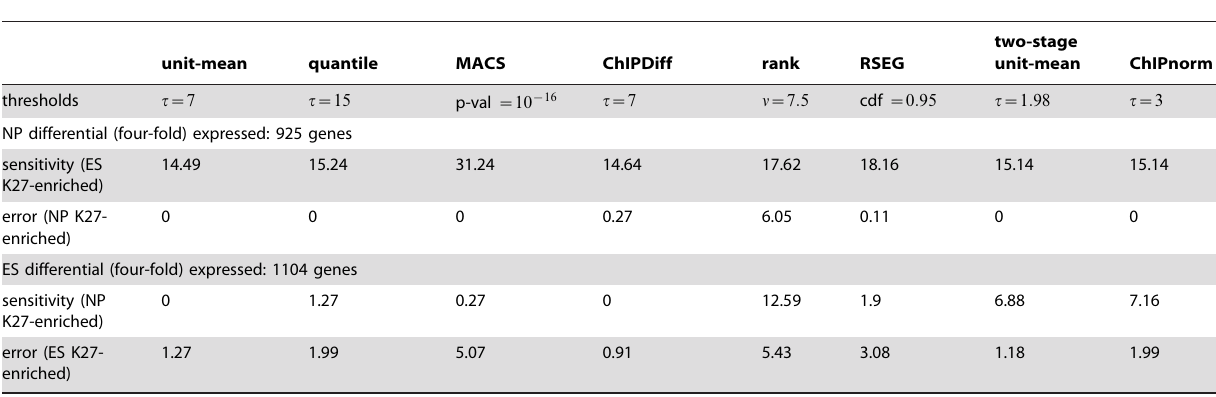
Table 1. Sensitivity analysis percentages using various methods (data from Mikkelsen et al. 2007 [8]).